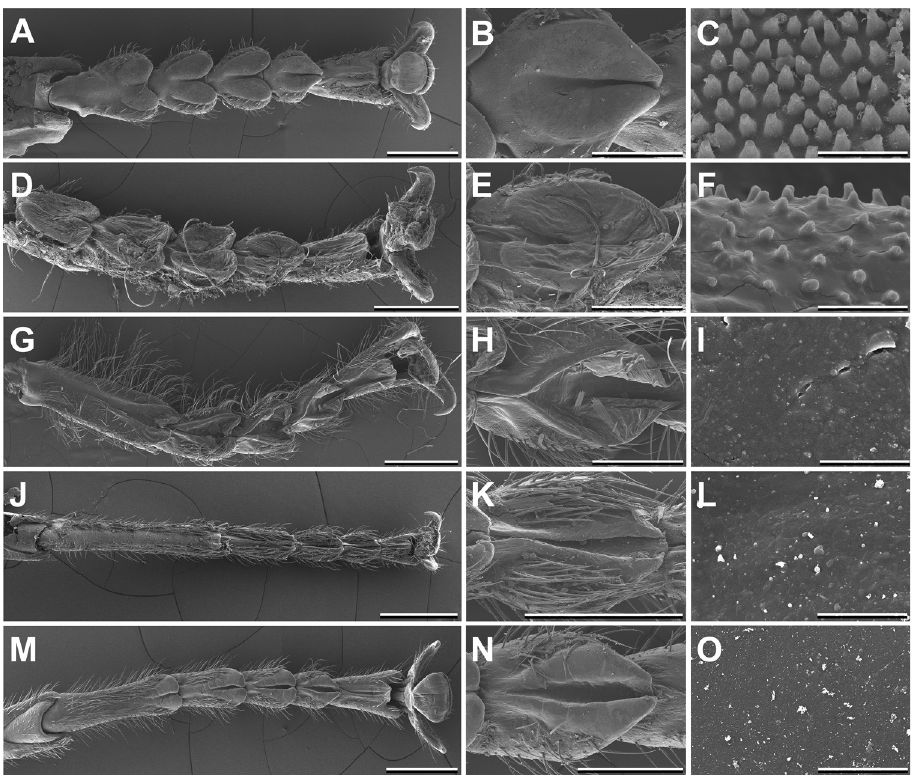
Figure 1. Scanning electron micrographs of the tarsal morphology of different Prisopodinae species. From left to right: Overview; Fourth euplantula; Adhesive microstructure. Scale bars: 1 mm; 300 μm; 5μm. Melophasma antillarum , female ( A–C ). Paraprisopus merismus , female ( D–F ). Prisopus horstokkii , female ( G–I ). Dinelytron grylloides , female ( J–L ). Damasippus sp., female ( M–O